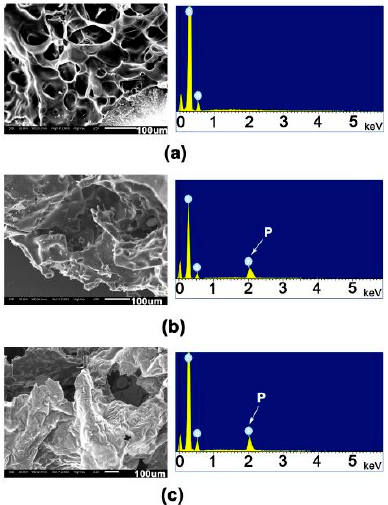
Figure 10. SEM images and EDX patterns of char layers in PI films after ignition. ( a ) PI-1; ( b ) PI-2; and ( c ) PI-3.